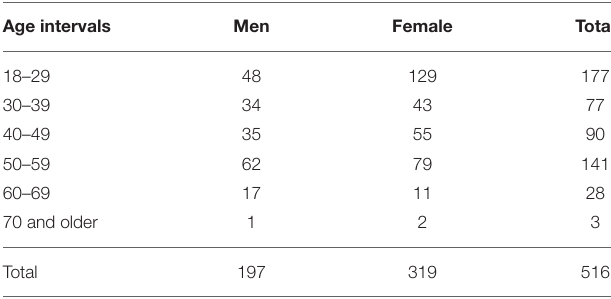
TABLE 1 | Sample distribution by age and